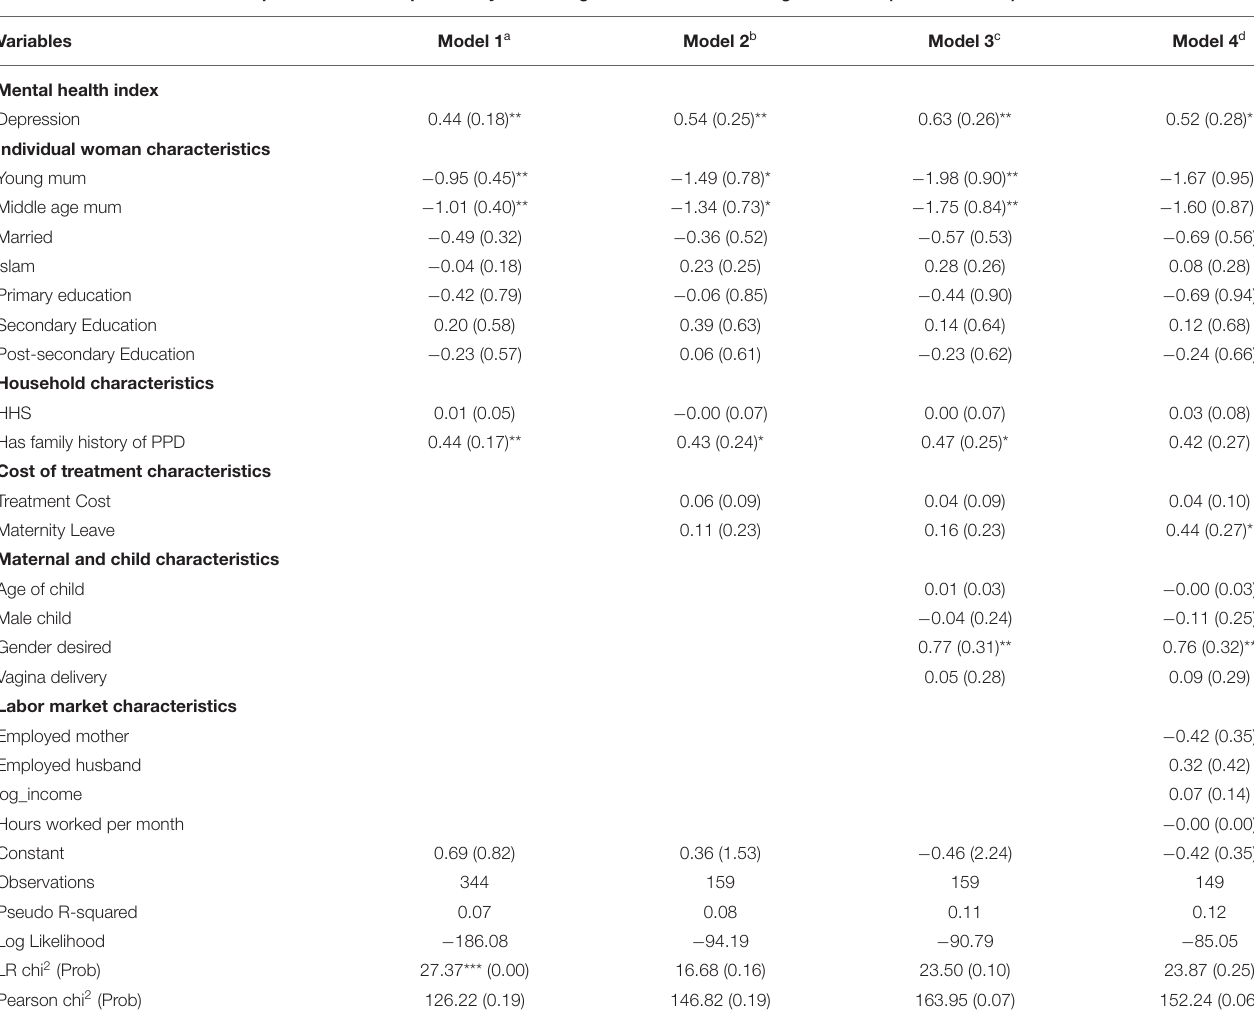
TABLE 3 | Probit regression results of determinants of probability of seeking mental